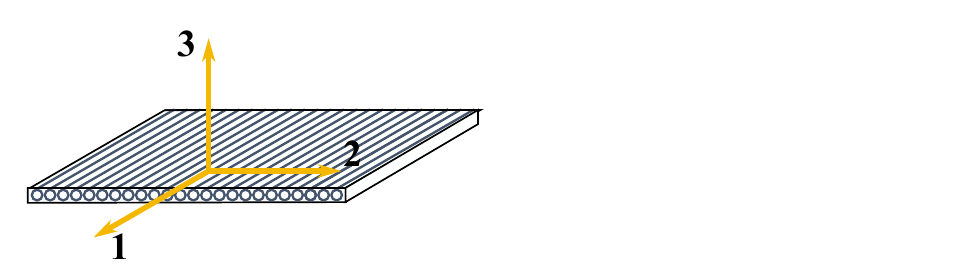
Figure 3. Material reference system of a layer featuring linear infill. All the filaments are parallel to direction 1, which lies on the building platform together with direction 2. 3 is the out-of-plane direction, orthogonal to the building platform.